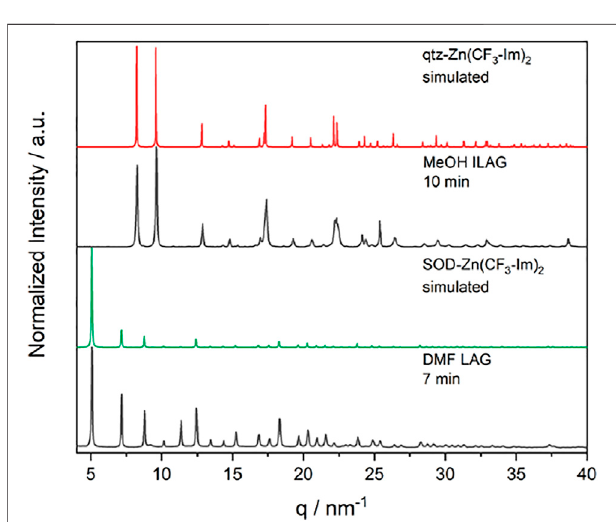
FIGURE 4 | XRD of as-synthesized powders by DMF LAG and MeOH ILAG (both black) and simulated diffractograms of SOD-Zn(CF 3 -Im) 2 (green) and qtz-Zn(CF 3 -Im) 2 (red), indicating full conversion by ball